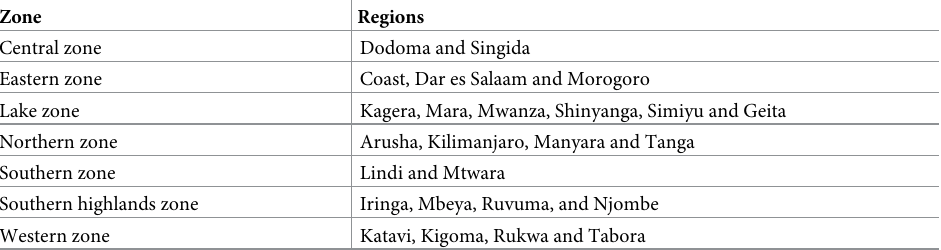
Table 1. Geopolitical zones of